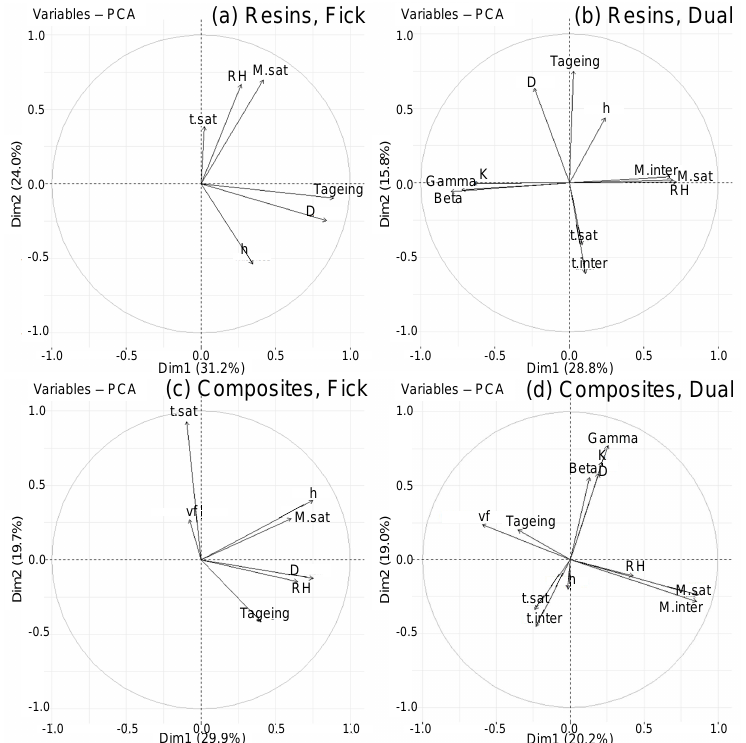
Figure 15. Correlation circles on the 1–2 planes of classified PCA: ( a ) Fick resins, ( b ) Dual resins, ( c ) Fick composites and ( d ) Dual composites. Further planes are given as Supplementary Materials: Fick resins in Figure S21, Fick composites in Figure S22, Dual resins in Figure S23 and Dual composites in Figure